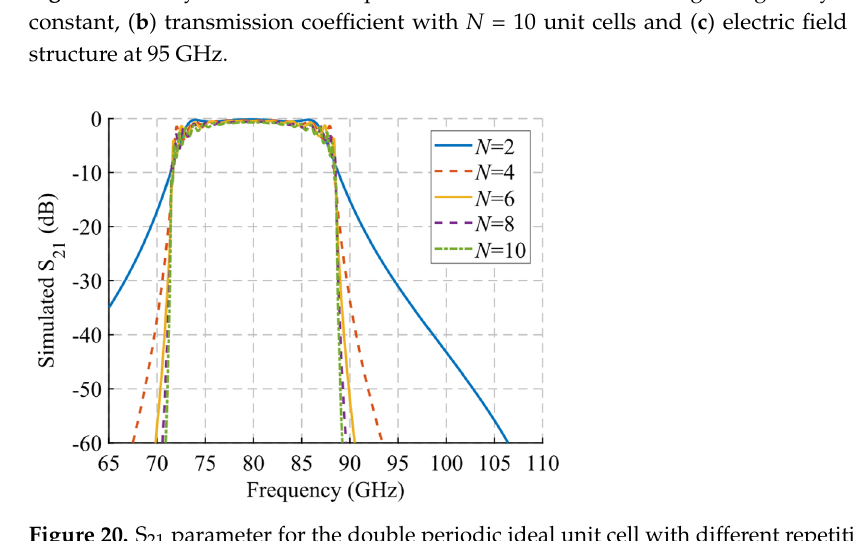
Figure 20. S 21 parameter for the double periodic ideal unit cell with different repetition number N of the unit cell at maximum symmetry breakage ( d = 0). the unit cell at maximum symmetry breakage ( d =